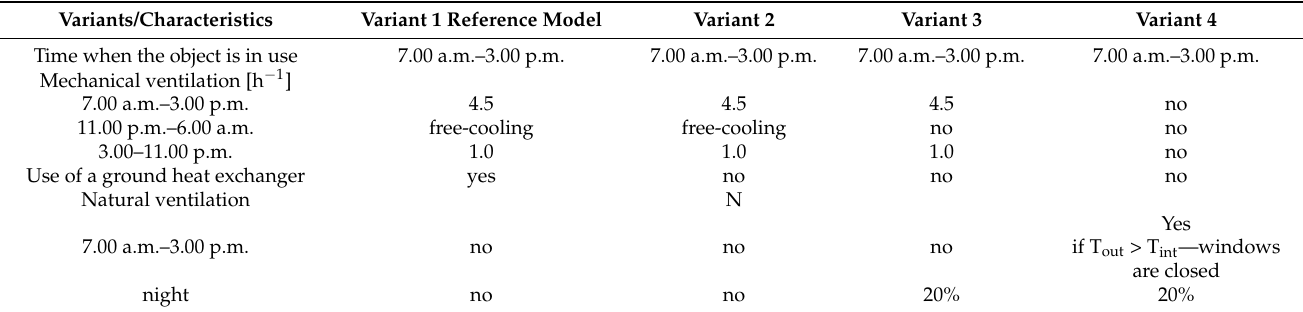
Table 2. Summary of assumptions for the simulation variants adopted.